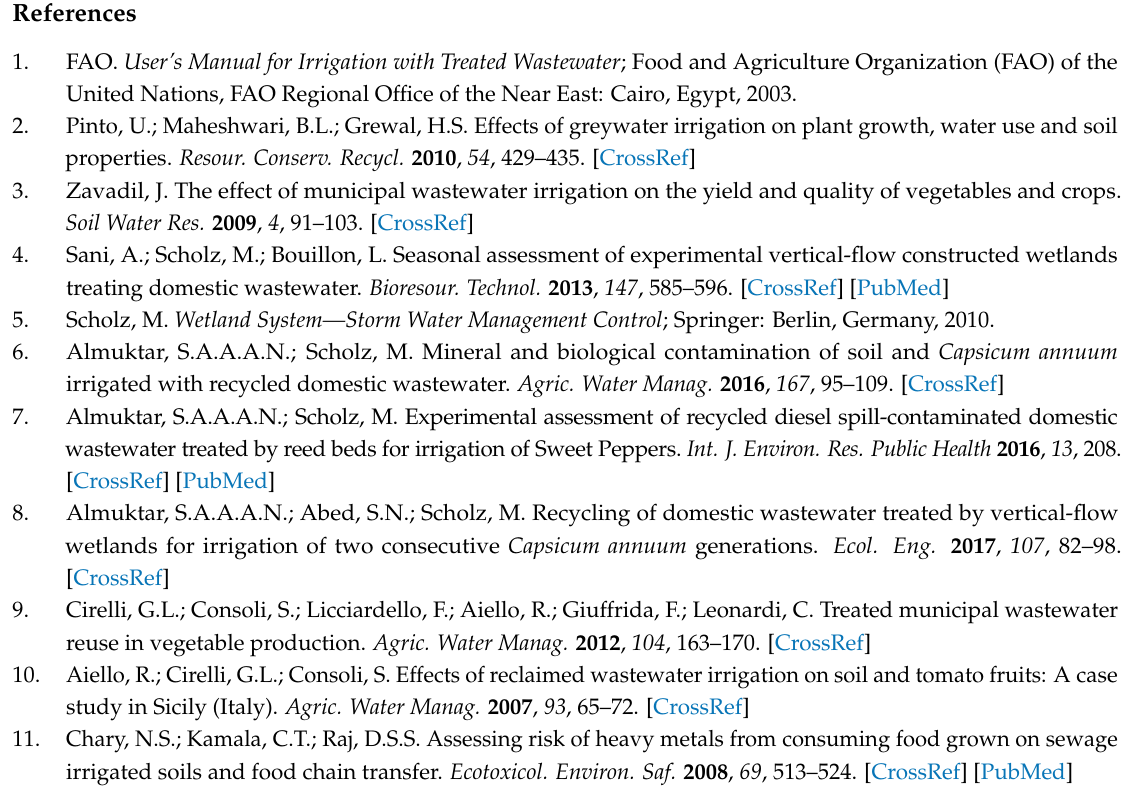
Table S1: Statistically significant differences in properties of soil subjected to different irrigation water types, Table S2: Correlation coefficients and associated significances between soil elements using the non-parametric Spearman correlation, Table S3: Overview of the statistically significant differences for elements within the harvested fruits, Table S4: Differences in Chilli fruit mean element concentrations harvested from mother and generation